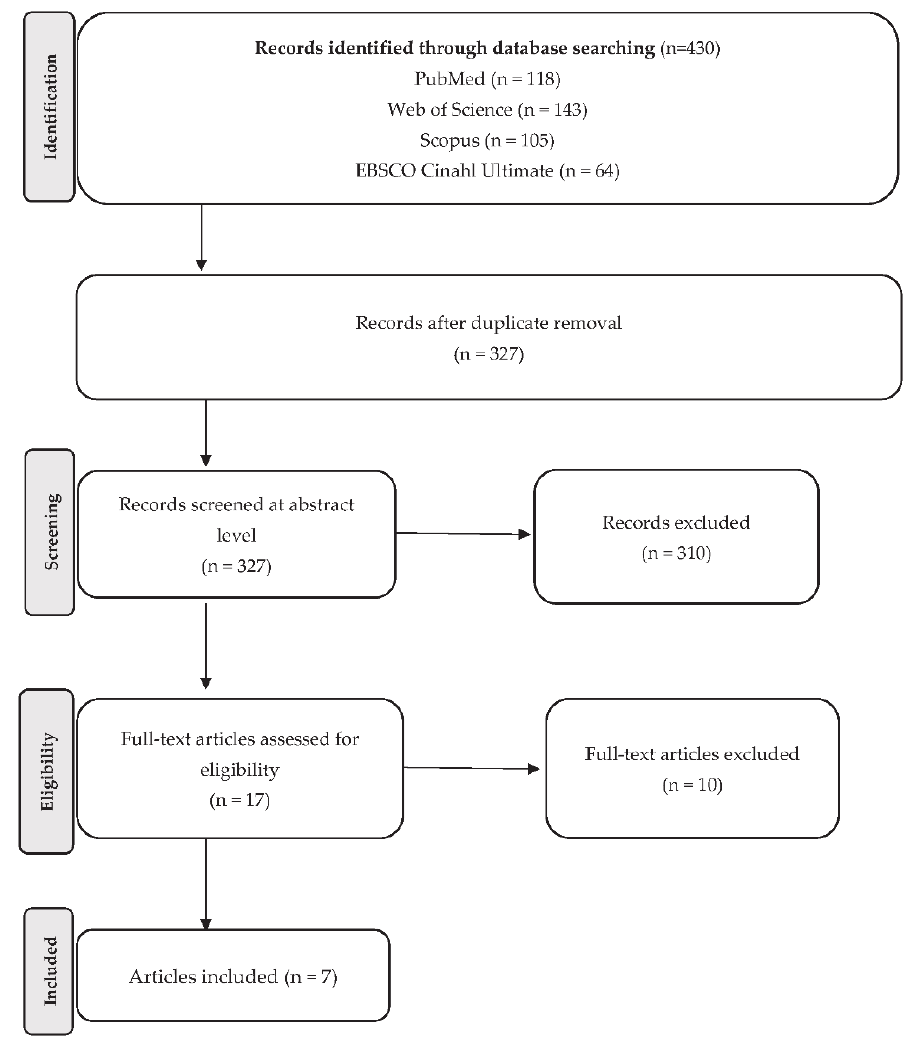
Figure 1. Flow diagram of the selection process according to Preferred Reporting Items for Systematic Review and Meta-Analysis (PRISMA) [29].